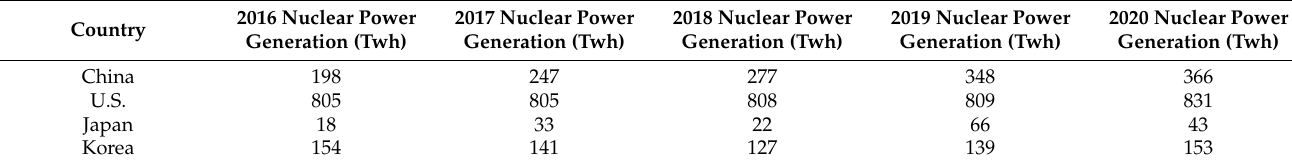
Table 2. Commercial Nuclear Power Generation in China, U.S., Japan and South Korea, 2016–2020.